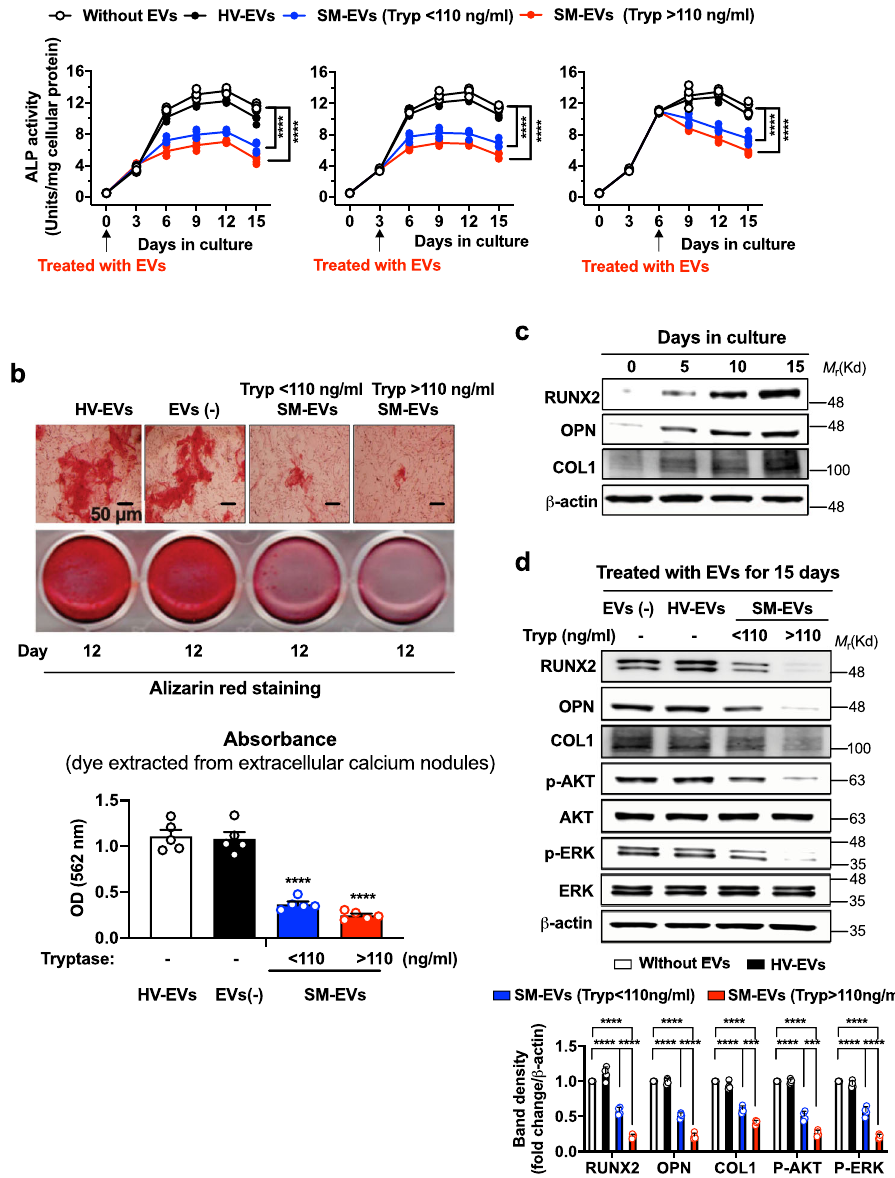
Fig. 2 SM-derived EVs inhibit differentiation and mineralization of hFOB1.19 pre-osteoblasts. a Effect of extracellular vesicles (EVs) isolated from the serum of healthy volunteers (HV-EVs) or of patients with systemic mastocytois (SM-EVs) on the differentiation of hFOB1.19 osteoblasts. Osteoblasts were plated at 39.5 °C and after 2 h (left panel), 3 days (middle panel) or 6 days (right panel), treated with a pool of EVs from the indicated groups (100 µ g). Media were replaced every 3 days and EVs replenished at the same time. Supernatants were collected to measure alkaline phosphatase (ALP) activity. Results are expressed as units per mg of cellular protein in each well. A two-way ANOVA was used for statistic comparison of the curves. **** p < 0.0001 compared to untreated cultures. Individual data points are shown and often overlap ( n = 5 biological replicates in a representative experiment). Empty circles are untreated cells; black circles, cells treated HV-EVs; blue and red circles are, respectively, cells treated with SM-EVs of patients with serum tryptase lower (SM-EVs (Tryp < 110 ng/ml)) or greater (SM-EVs (Tryp > 110 ng/ml) than the median (110 ng/mL). b Effect of SM-EVs as de fi ned above on calcium deposition by osteoblasts using alizarin red staining. hFOB1.19 were plated and treated with EVs as in a (left panel) for 12 days. The top picture shows osteoblasts under a microscope (20×) to illustrate the effect of EVs on extracellular calcium deposition (visualized in red). Scale bar is 50 µ m. The picture underneath is a macroscopic picture of the wells during extraction of the dye from the calcium nodules. The extracted dye was quanti fi ed by absorbance at 562 nm (bar graphs). Data show the mean ± SEM of n = 5 biological replicates of a representative experiment. **** p < 0.0001 using an unpaired Student t -test (two-tailed). c Changes in RUNX2, OPN, and COL1 expression during differentiation of hFOB1.19 determined by Western blotting. d Effect of HV-EVs and SM-EVs (as de fi ned in a and using the same color scheme, also indicated in the legend), on the expression of RUNX2, OPN, and COL1 and phosphorylation of AKT and ERK. The histograms represent band intensity changes shown as mean ± SD of n = 4 independent experiments. In c and d , β -actin was used as a loading control. Total AKT and ERK are also shown in d . *** p < 0.001 ( p = 0.0008 in COL1 and p = 0.0009 in p-AKT) and **** p < 0.0001, using an unpaired Student t -test (two-tailed). Data in a – d are from representative experiments of at least three independent experiments showing similar